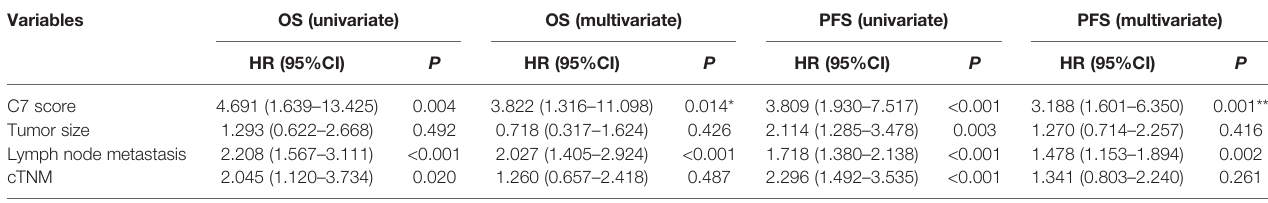
TABLE 3 | Univariate and multivariate analysis for the overall survival (OS) and progression-free survival (PFS) in IDC patients. Variables OS (univariate)